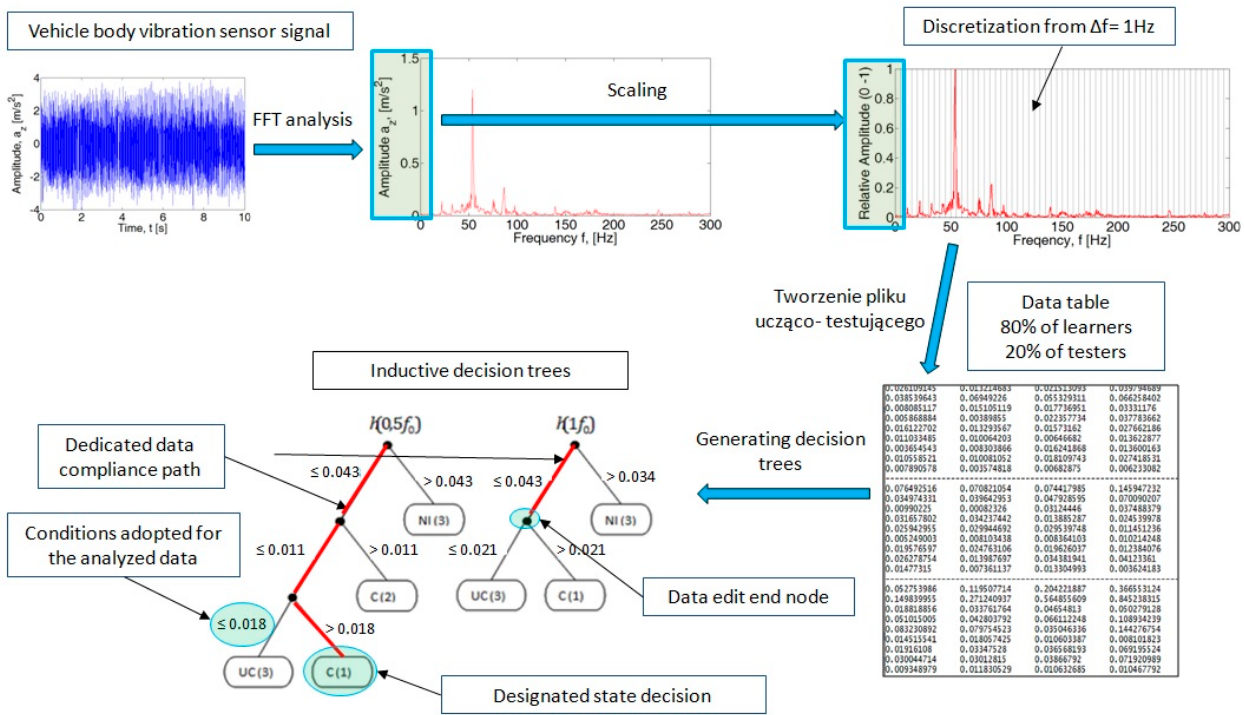
Figure 3. Example of acceleration sensor signal for a low-speed engine .